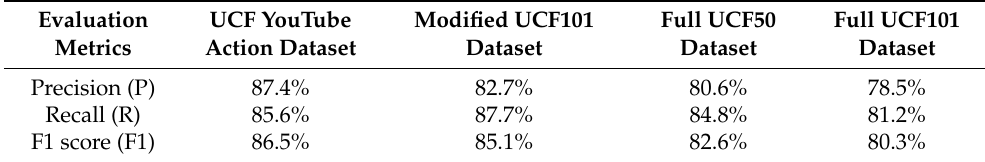
Table 3. The evaluation criterion of the proposed neural network architectures using different datasets.